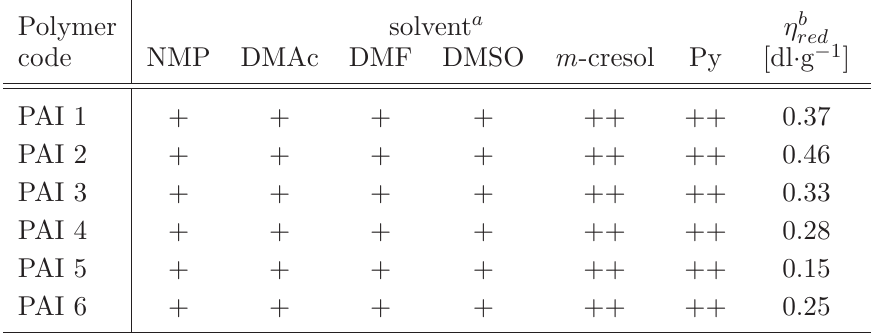
Table 1 Solubility and reduced viscosity of the poly(amideimide)s.